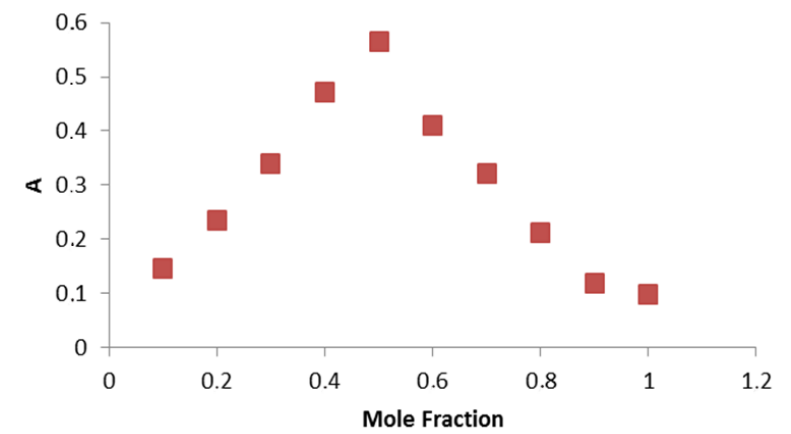
Figure 2. The continuous variation plot for the stoichiometry of the reaction of MPT and